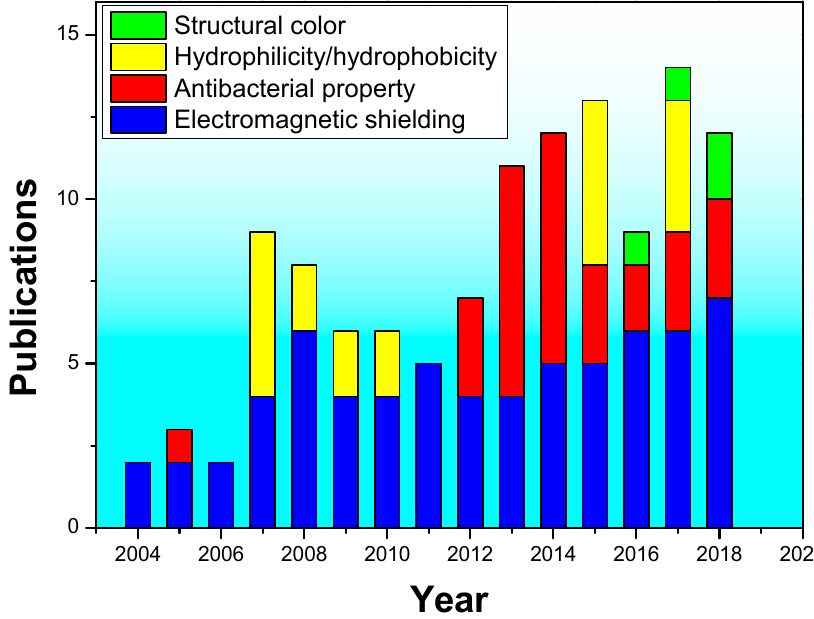
Figure 1. The amount of literatures on magnetron sputtering functional textiles in recent years .